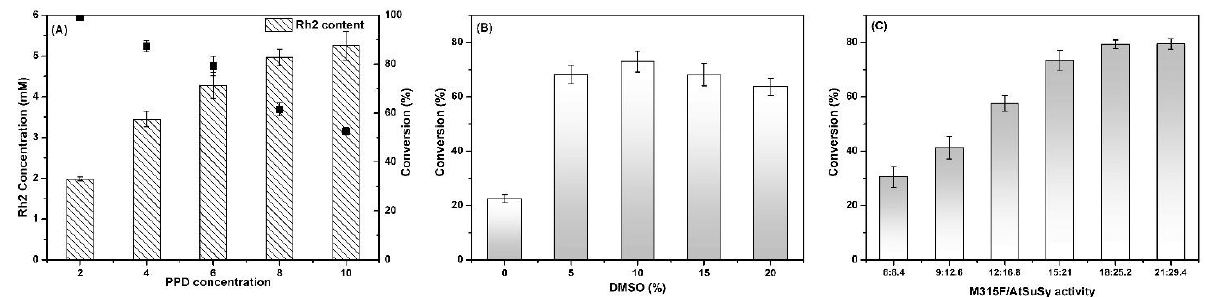
Figure 4. Optimization of the conditions for co-immobilized M315F and At SuSy coupled reactions. Effect of PPD concen- tration on the Rh2 production by co-immobilized M315F and At SuSy catalyzed reactions ( A ), conversion yield ( ■ ) was recorded. Effect of co-solvent DMSO on the yield of Rh2 by co-immobilized M315F and At SuSy catalyzed reactions ( B ), and influence of different co-immobilized M315F and At SuSy usage on the glycosylation reaction for Rh2 formation ( C ).